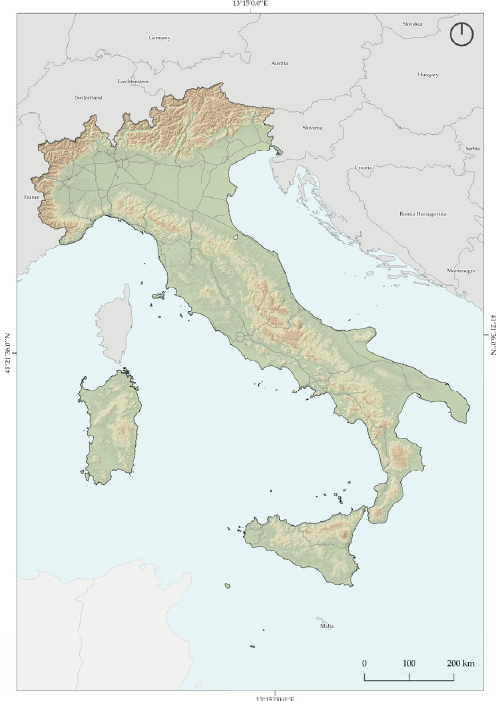
Figure 2. Study area—the analysis refers to the whole Italian territory, which is represented with reference to orography and major road infrastructure. reference to orography and major road